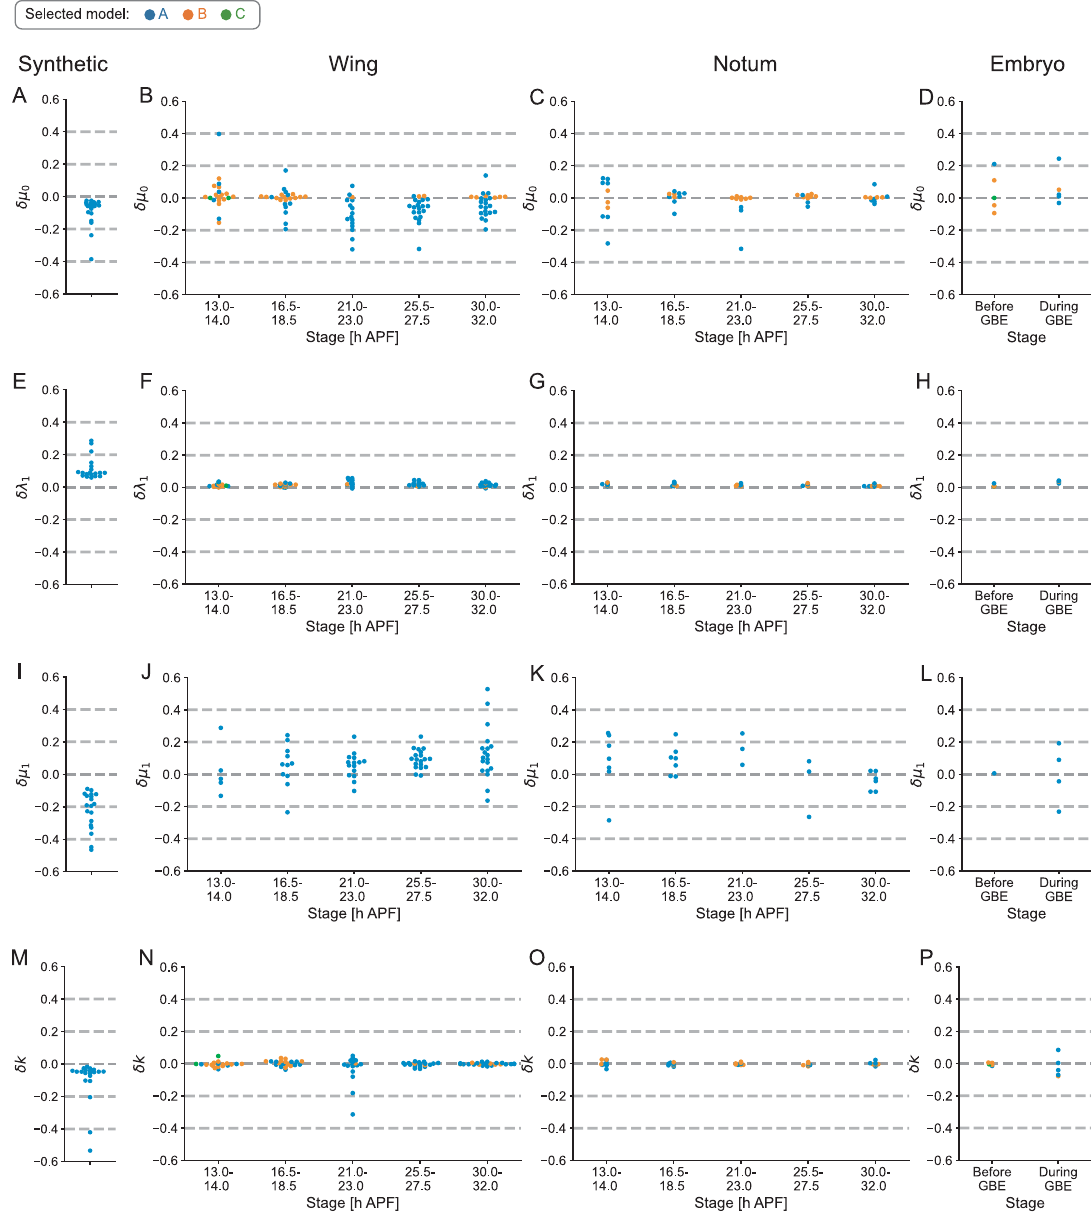
Fig 4. Evaluation of robustness to image processing error. (A–P) A noise resistance test on the estimation of μ 0 (A–D; the anisotropy in the line tension), λ 1 (E–H; the spring constant of junction), μ 1 (I–L; the anisotropy in the spring constant of junction) and k (M–P; the elastic modulus of cells). Parameters were estimated from the original data and noised data sets. Each dot shows the median value of the deviations of estimated parameters in 100 noised data sets (Materials and Methods) for each synthetic data (A, E, I, M) or each input image at the stage indicated in the pupal wing (B, F, J, N), pupal notum (C, G, K, O), and embryo (D, H, L, P). Dot colors represent a model used for parameter